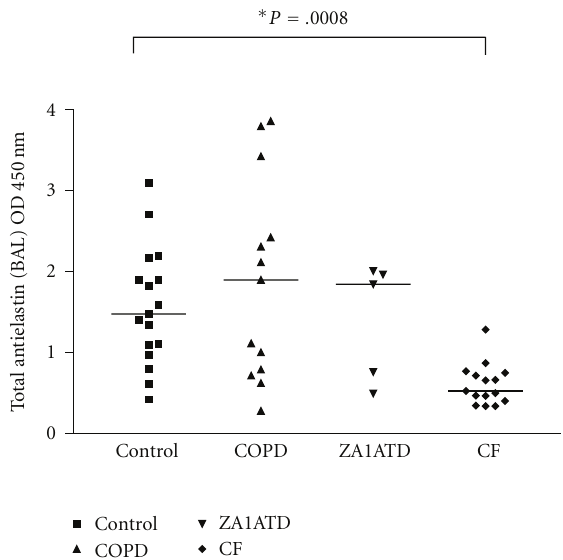
Figure 1: Total antielastin antibodies in bronchoalveolar lavage fluids were quantified in control ( N = 11), COPD ( N = 14), Z- A1ATD ( N = 5) and CF ( N = 15) samples by ELISA.